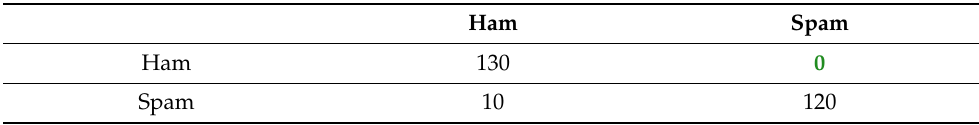
Table A6. MNB (1) and MNB (2) confusion matrix in Substage